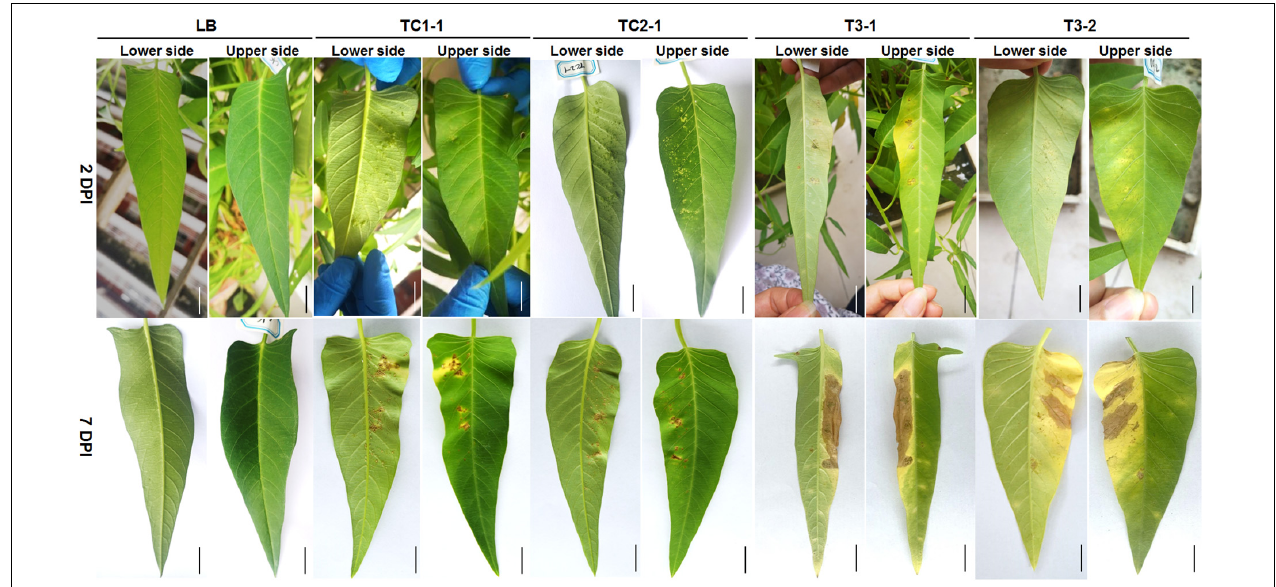
FIGURE 3 | Symptoms of water spinach after inoculation with LB, strains TC1-1, TC2-1, TC3-1, and TC3-2, respectively. Photos were taken after 2 and 7 DPI (days post inoculation), respectively. Scale bar = 1